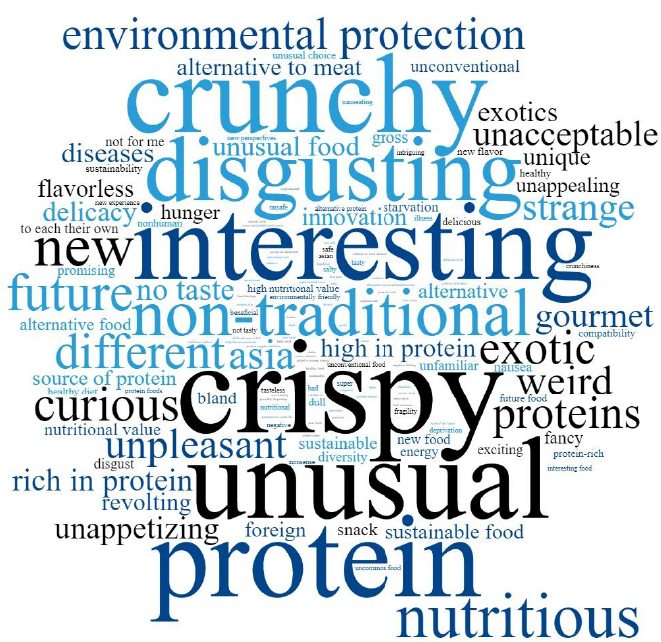
Figure 2. Word map of answers to the question “What comes to your mind when you hear about edible insects?”. Respondents were allowed to write up to 5 answers. Words are scaled by fre- quency.